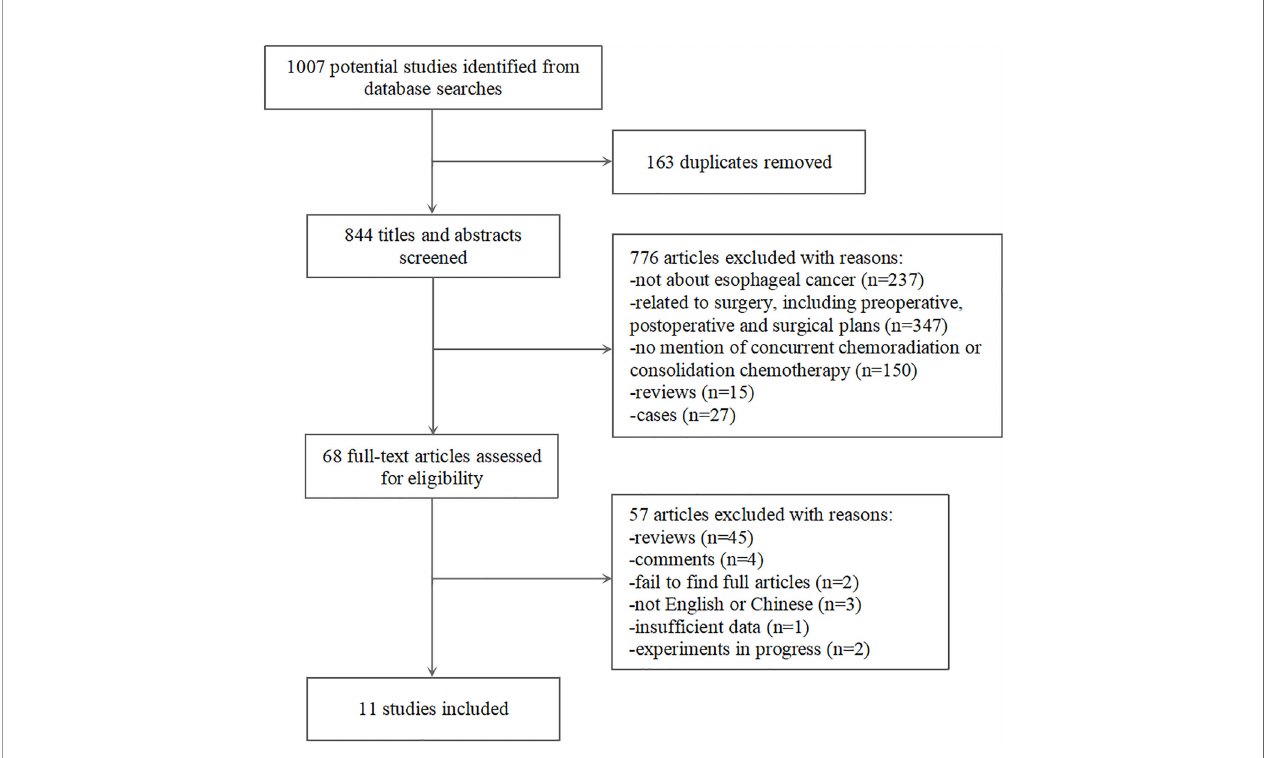
FIGURE 1 | Flow chart of the study selection